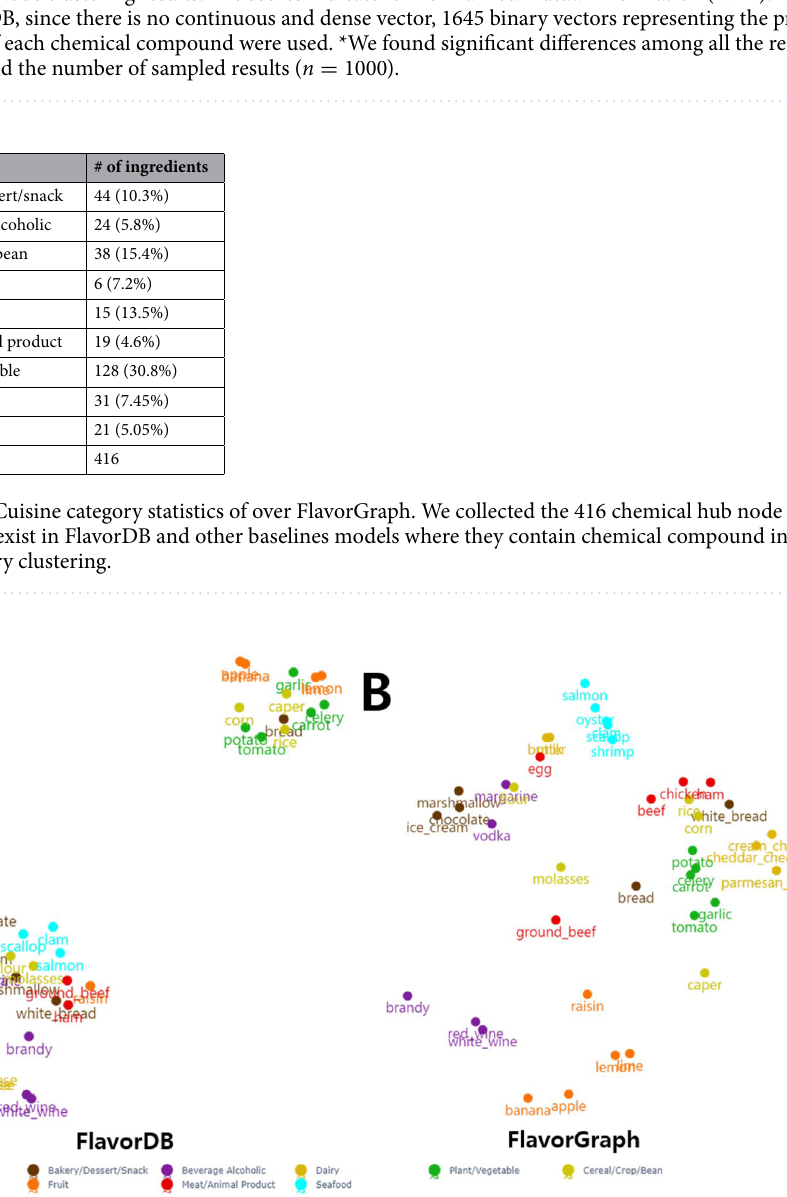
Figure 4. 2D t-SNE projection of the 300-D embeddings of 40 food ingredients, five from each of the eight food categories. ( A ) FlavorDB ( B ) FlavorGraph